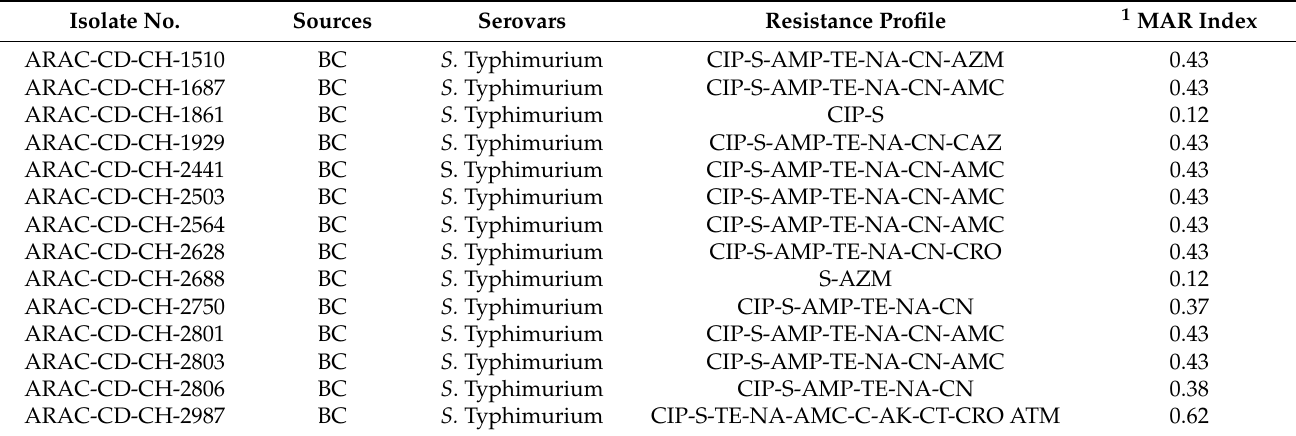
Table 2. AMR patterns and MAR index of S. Typhimurium and S. Enteritidis isolated from chicken at wet markets. Isolate